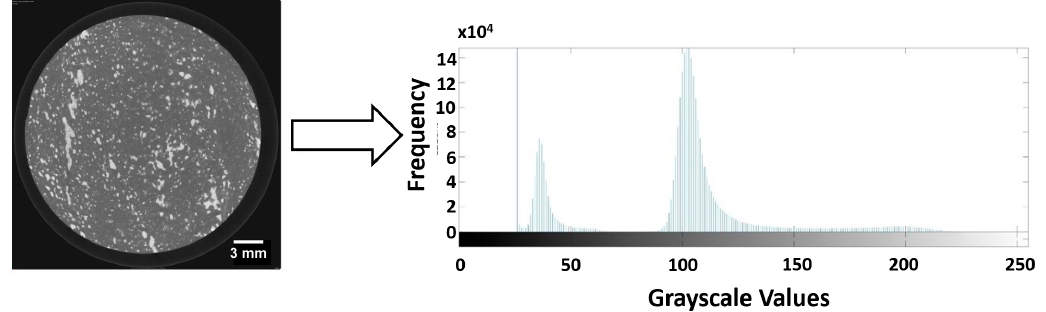
Figure 4. Histogram of gray values of a 2D slice. The two peaks indicate a clear threshold value for separating two classes, which in this case are the background (left peak) and the drill core (right peak). Note that further thresholding for the phases within the drill core would be challenging as it seems difficult to separate the right peak into several peaks (phases).